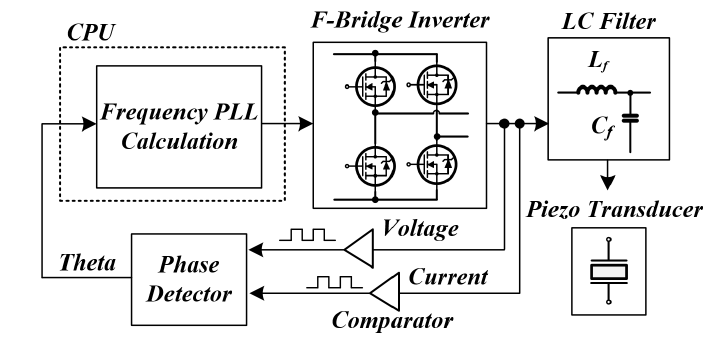
Figure 8. Block diagram of conventional resonance tracking